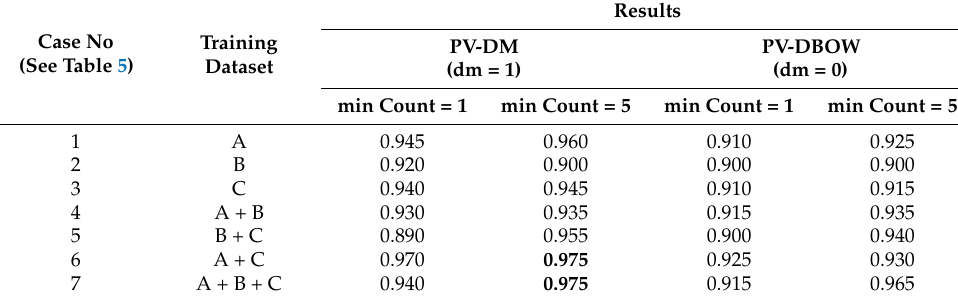
Table 9. Results of Experimental setup